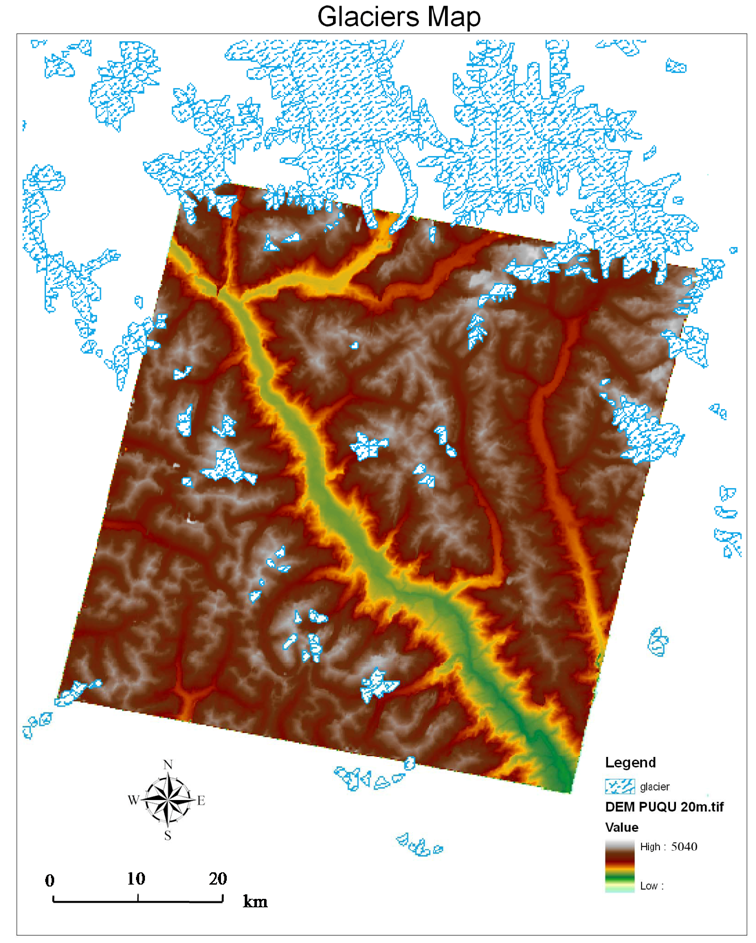
Figure 9. Distribution of glaciers in the Puqu Fault region as shown in the glacier map acquired from the Chinese Glacier Information System